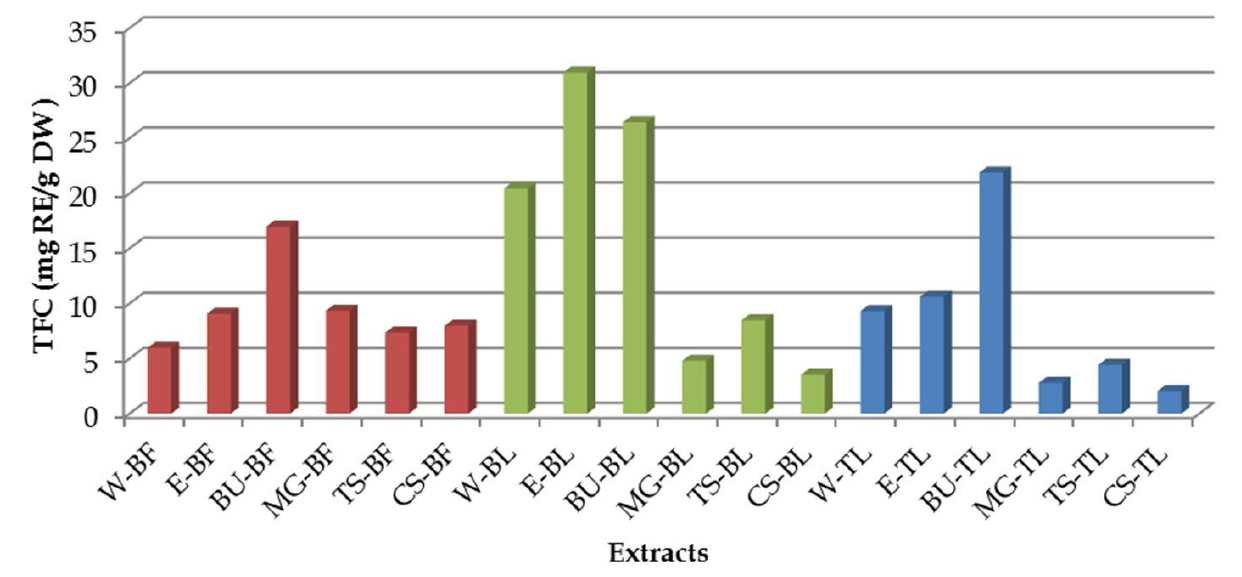
Figure 2. Total flavonoid content (TFC) in the investigated extracts (the abbreviationsare listed in Table 2).